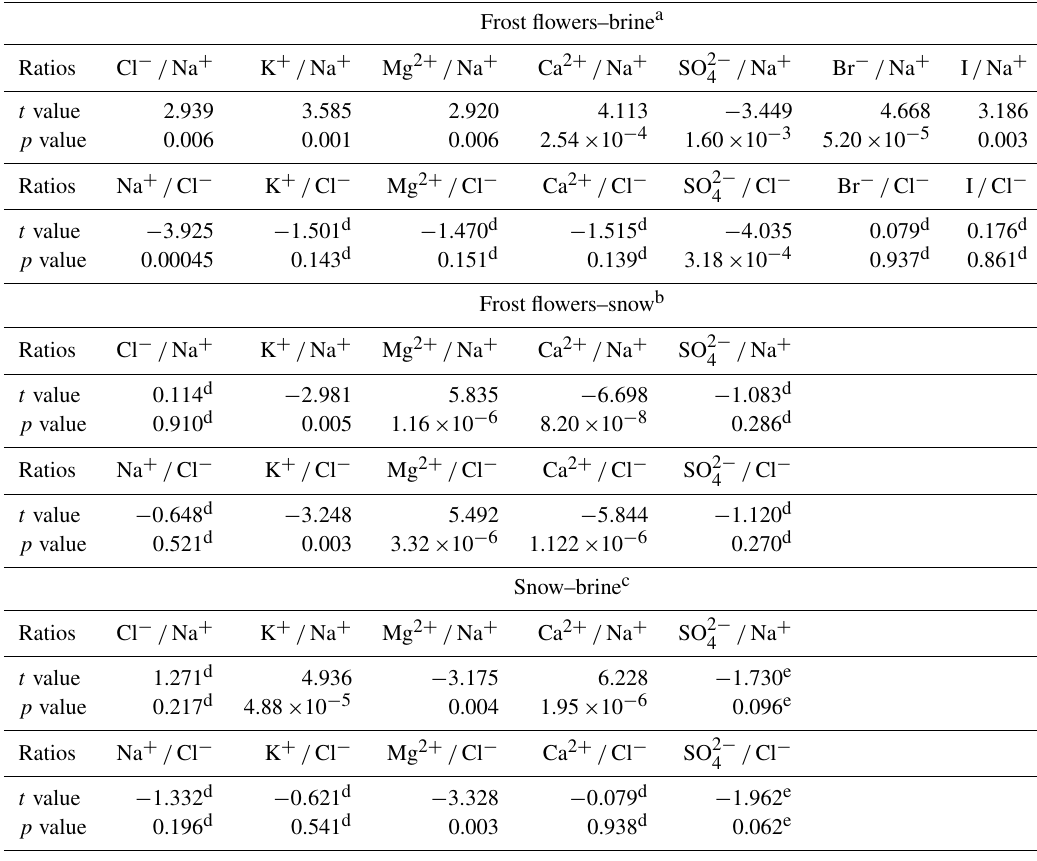
Frost flowers–brine